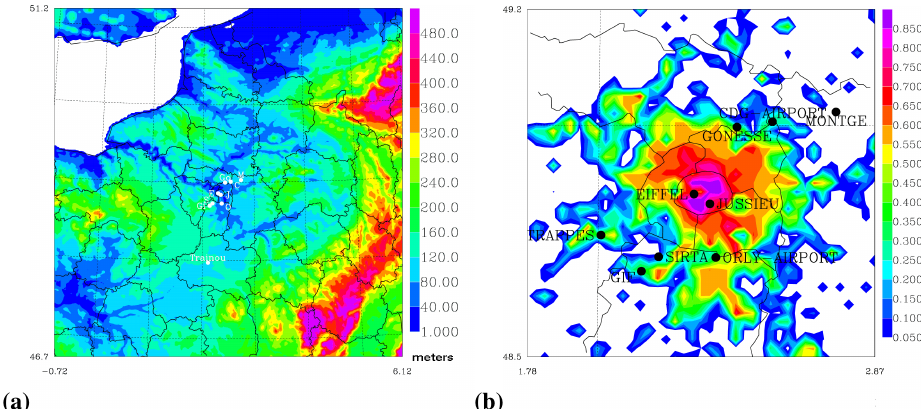
Fig. 1. (a) : Domain of simulation with orography (in ma.s.l.). (b) : Zoomed-in view on Ile-de-France province with urban fraction. The observational stations (Montge, Gonesse, Eiffel, Jussieu, Trappes, SIRTA, Gif) and airports (CDG and Orly) are labelled on both panels.